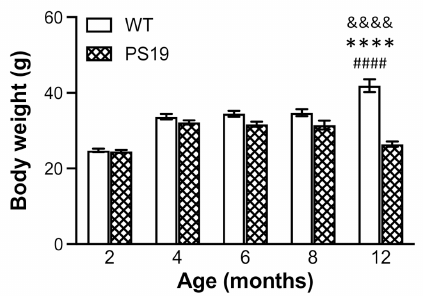
Figure 1. Mean ( ± SEM) body weights (g) of male wild-type (WT) and PS19 mice at 2, 4, 6, 8 and 12 months of age ( n = 11–15/genotype/age). &&&& indicates a significant genotype and age interaction at p < 0.0001. **** indicates a significant genotype effect at p < 0.0001. #### indicates a significant age effect at p <